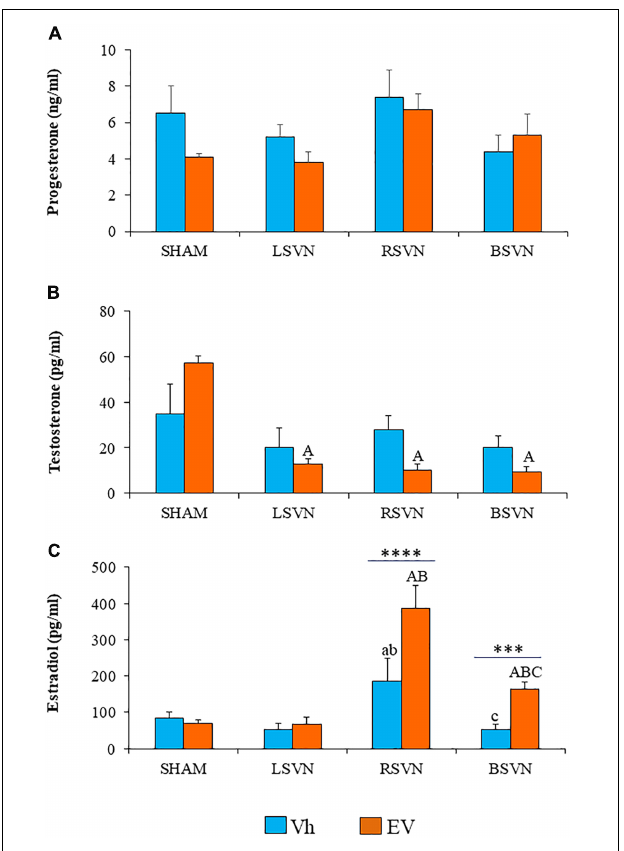
FIGURE 2 | Steroid hormone concentrations. Mean ± SEM progesterone (A) , testosterone (B) , and estradiol (C) serum concentrations in rats injected with vehicle (Vh) or estradiol valerate (EV) at day 10 of life, with sham-surgery (sham) or unilateral (LVNS or RVNS) or bilateral (BVNS) vagotomy at day 76 of life, and sacrificed at day 80–82 of life. a vs. Vh-sham; b vs. Vh-LVNS; c vs. Vh-RVNS; A vs. EV-sham; B vs. EV-LVNS; C vs. EV-RVNS, two-way ANOVA followed by Tukey´s multiple comparisons test. The line indicates the difference between groups ∗∗∗ p < 0.001, ∗∗∗∗ p < 0.0001, Student’s t